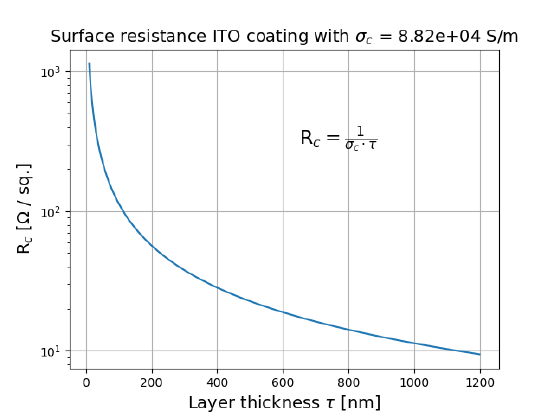
Figure 9. ITO surface resistance as function of layer thickness.